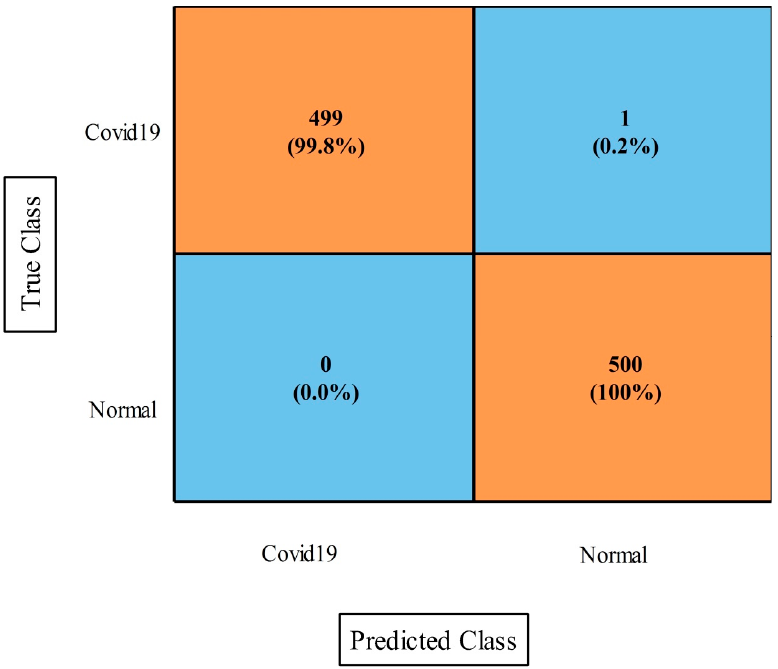
Figure 9. Proposed optimization confusion matrix of WNN classifier on COVID-19 Patients Lungs X-ray dataset.